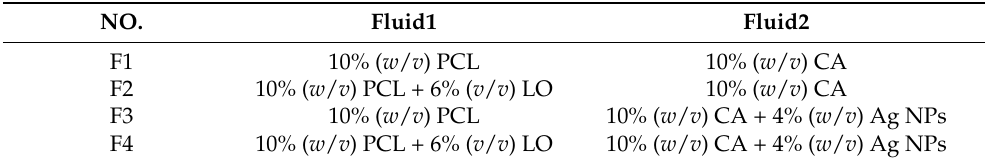
Table 1. Details of the working solutions used in this work.